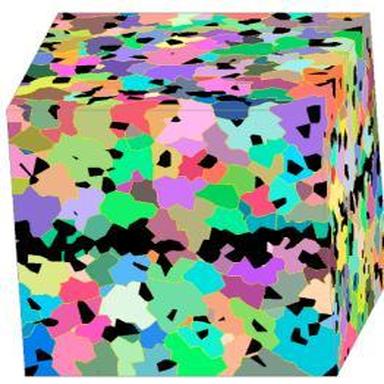
3D Dual Phase (DP) microstructures consisting of 1000 grains. Both microstructures have a second phase volume fraction of 15.6% (indicated in black color). Colors represent crystallographic orientations.